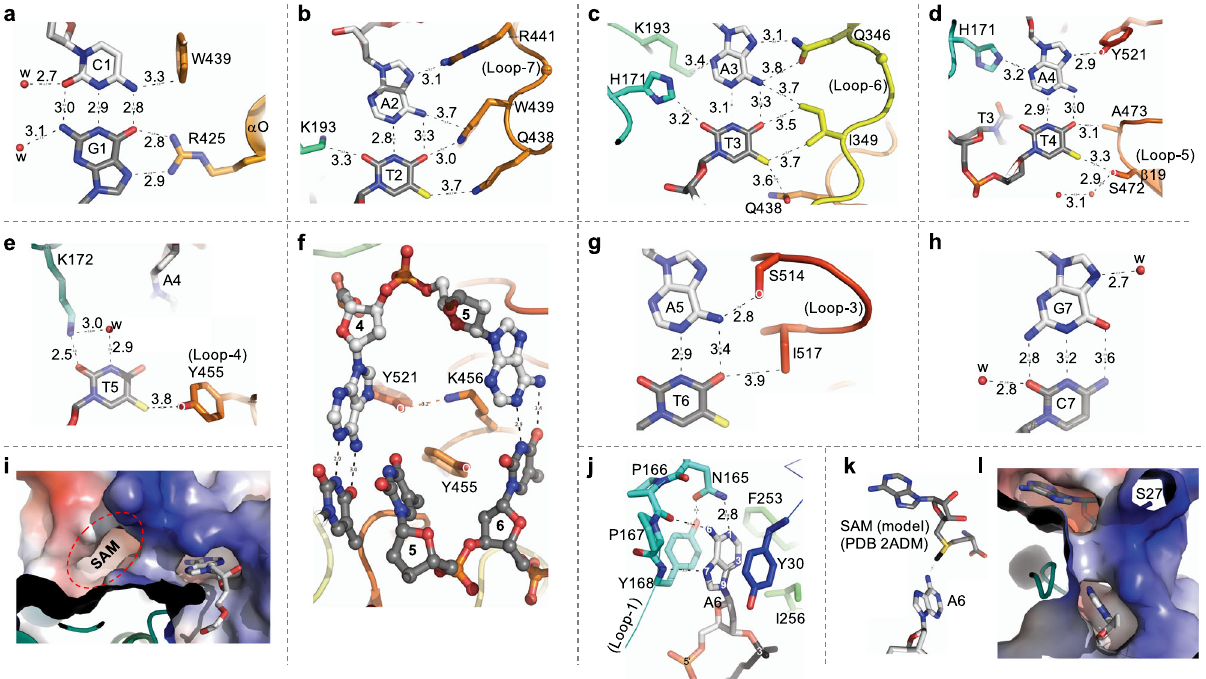
Fig. 4 CamA-mediated base-speci fi c recognition. a Interactions with C1:G1 base pair. Interatomic distances are shown in angstroms. b – d Interactions with A2:T2, A3:T3, and A4:T4 base pairs at both major (right) and minor (left) grooves. e Interactions with the orphan T5. f View from the DNA minor groove, with intercalation of TRD residues that occupy the space normally occupied by A5. g Interactions with the rearranged A5:T6 base pair. h Lack of protein- mediated contacts with G7:C7 base pair. i The fl ipped-out A6 bound in the active-site cage. The nearby SAM-binding pocket is empty in the current structure. j Interaction with the target A6 in the aromatic cage. k , l A modeled SAM molecule in the cofactor binding pocket. Label S27 indicates the fi rst ordered residue in the current